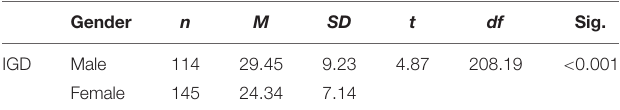
TABLE 5 | Summary of percentages of IGD_clinical compared to IGD_non-clinical on gender, age, academic, and gaming